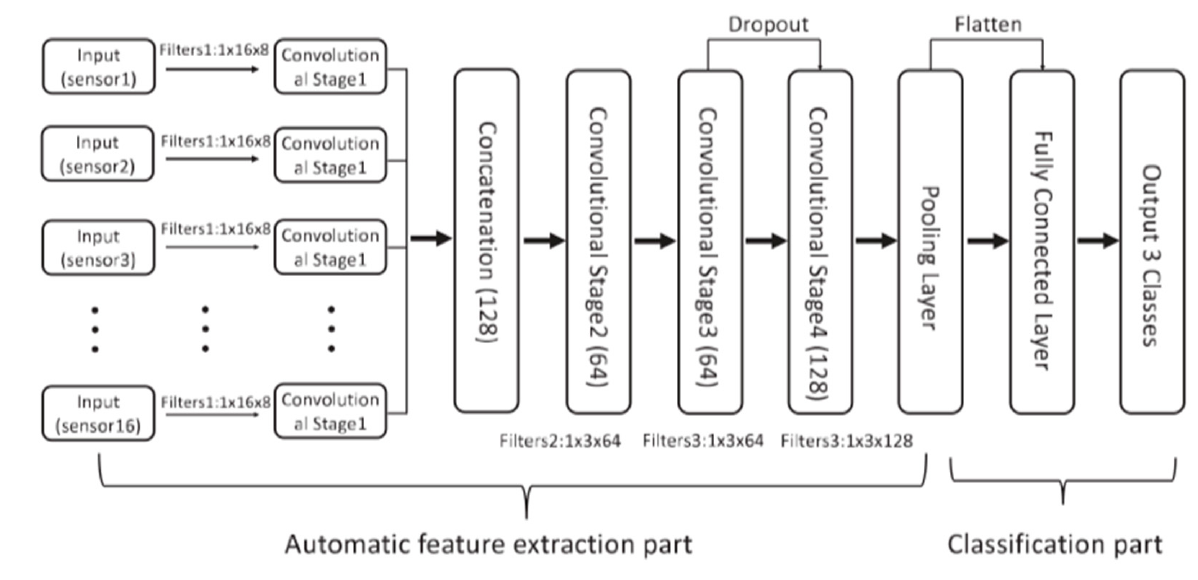
Figure 6. Architecture of 1d-DCNN algorithm [79].